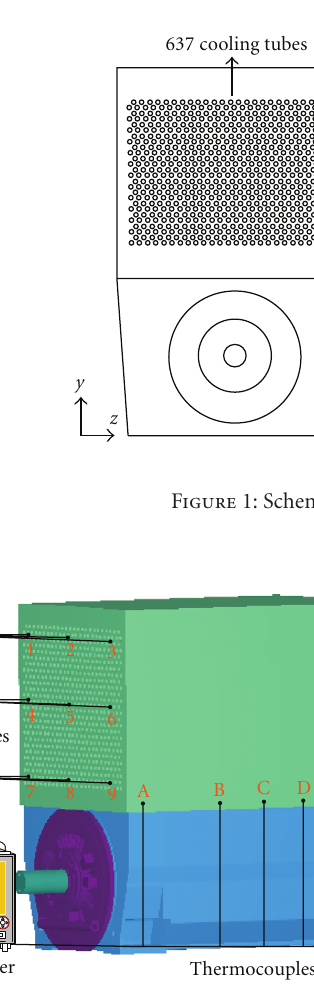
Figure 2: Measurement locations of the heat exchanger for the air- to-air cooled motor.